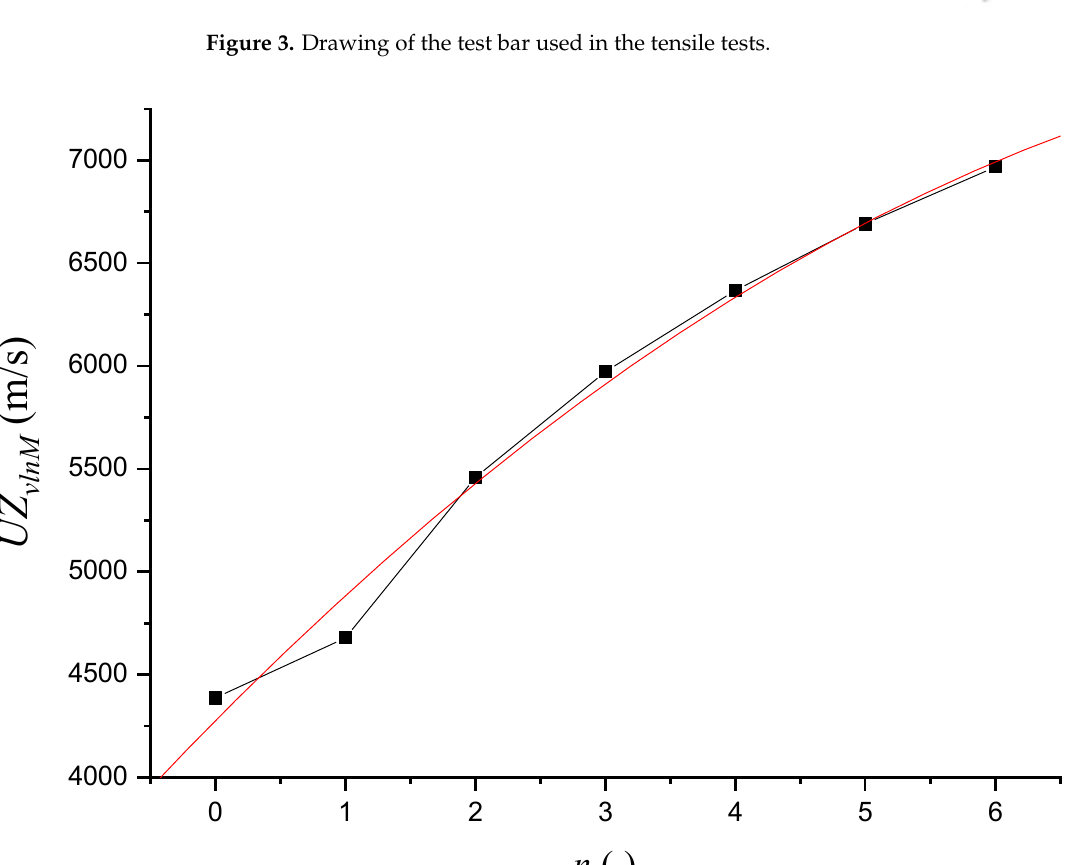
Figure 3. Drawing of the test bar used in the tensile tests.